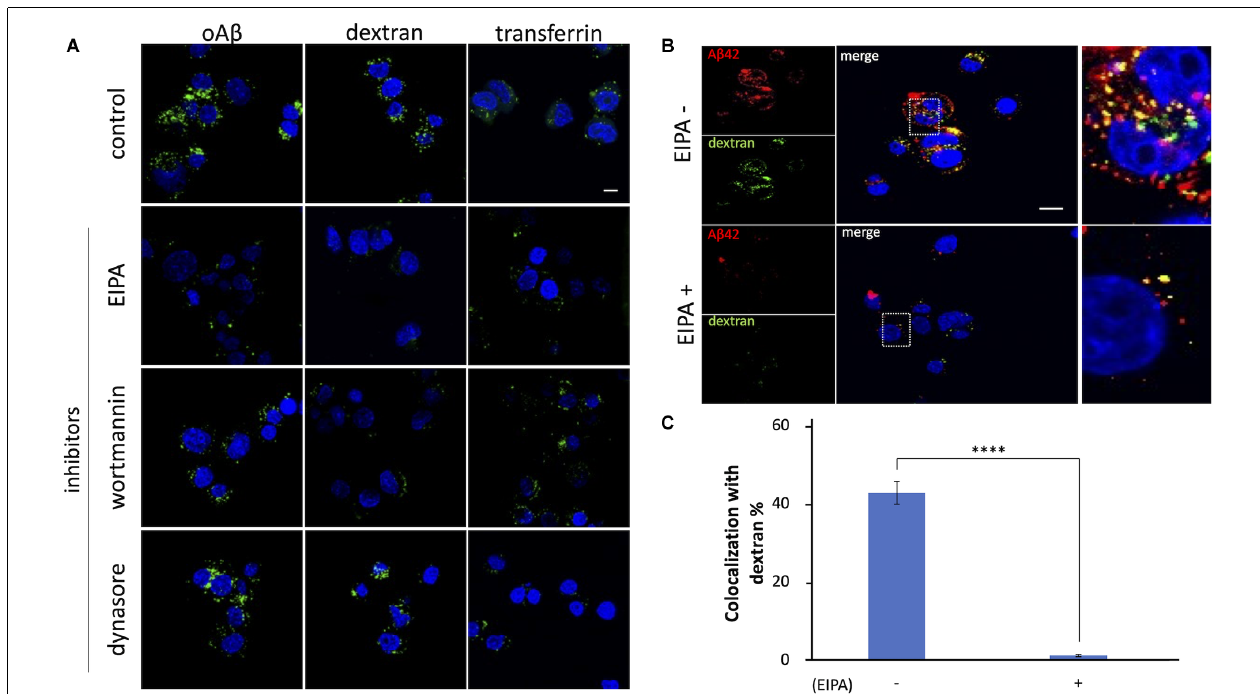
FIGURE 4 | Effects of inhibitors on the internalization of oA β 42 in Neuro2A cells. (A) Neuro2A cells were mock-treated or pretreated with 80 µ M EIPA, 300 nM wortmannin, or 80 mM dynasore for 1 h, followed by incubation with 5 µ M oA β 42, 2.5 mg/ml dextran, or 50 µ g/ml transferrin for an additional 90 min at 37 ◦ C, respectively. Nuclei were visualized with DAPI (blue). Scale bar = 10 µ m. (B) Neuro2A cells were treated with 5 µ M TMR-oA β 42 (red) and 2.5 mg/ml FITC-dextran (green) for 90 min in the absence or presence of EIPA. Yellow indicates colocalization. Nuclei were visualized with DAPI (blue). Enlarged views of the boxed region are shown in (B) (far right line). Scale bar = 10 µ m. (C) Quantification of the rate of coexistence of oA β 42 and dextran (colocalization/total) shows a marked reduction in the presence of EIPA. Experiments were repeated three times. Data are presented as mean ± SEM. Significance was established by Student’s t-test. ∗∗∗∗ p <